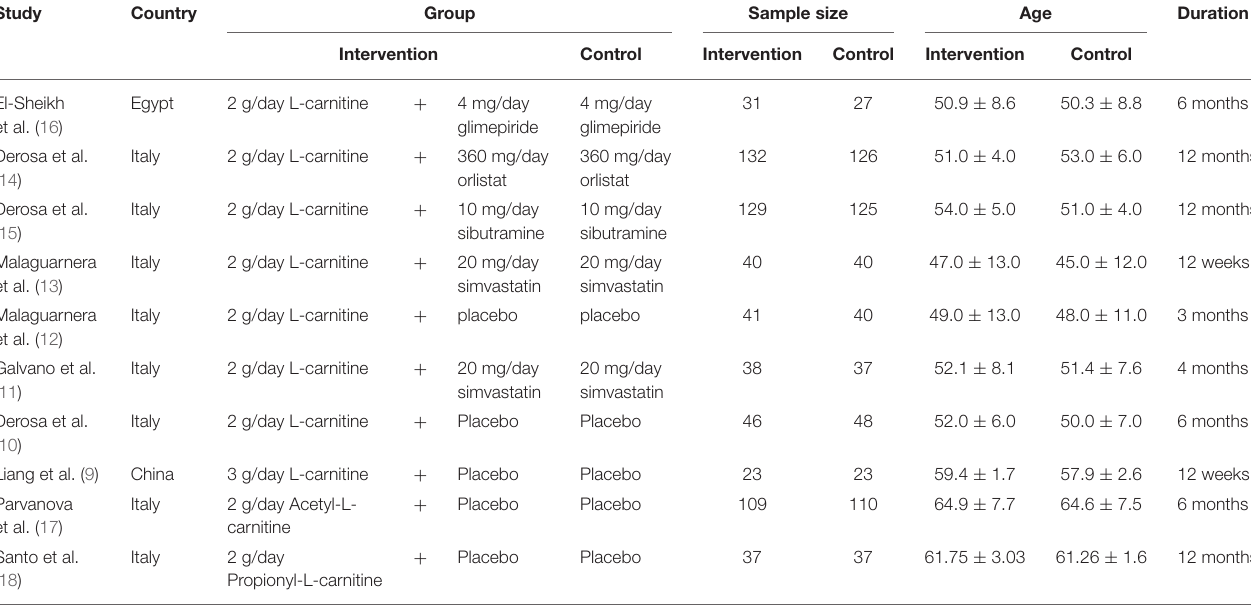
TABLE 1 | Included randomized controlled